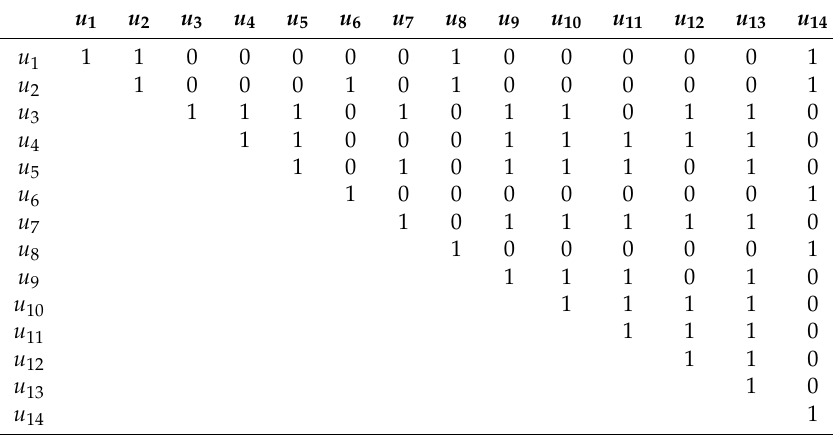
Table 4. Triangular indiscernibility matrix for concept-dependent granule generation ( i < j ), derived from Table